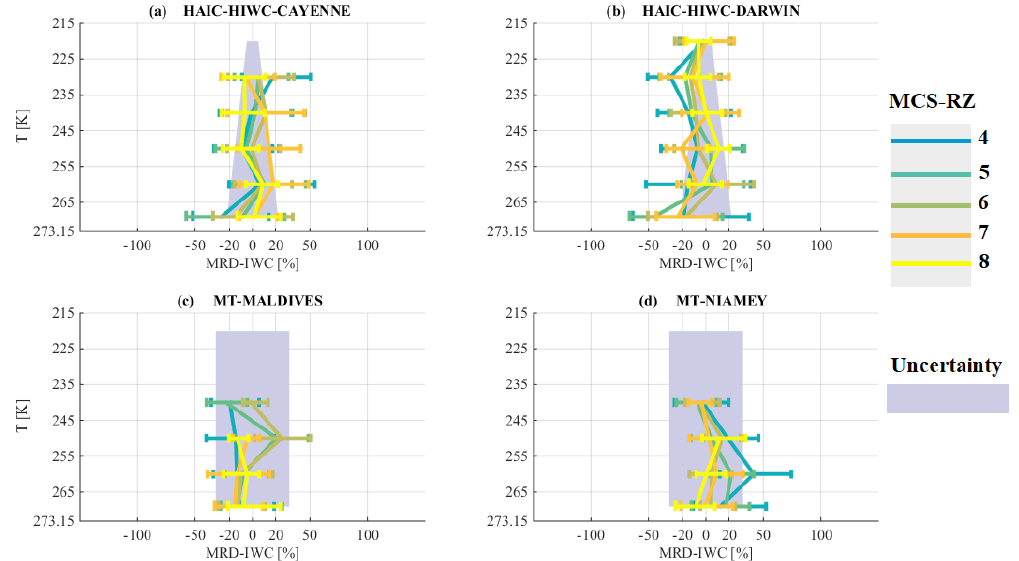
Figure 6. Median relative difference (MRD) of IWC during (a) HAIC-HIWC in Cayenne, (b) HAIC-HIWC in Darwin, (c) Megha-Tropiques in the Maldives, and (d) Megha-Tropiques in Niamey, with respect to the median of IWC for the merged dataset on the x axis as a function of temperature in K on y axis. The grey bands represent the uncertainties of the IWC measurement in (b) and (c) and the median deviation between the measurements and the IWC retrieval method (Fontaine et al., 2017) in (d) and (e) . Lines are color coded as a function of the MCS reflectivity zones where in situ measurements were performed. The extremities of the error bar show the 25th and 75th percentiles of IWC relative error in each MCS reflectivity